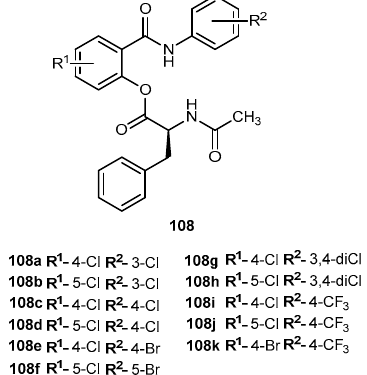
Figure 45. Structures of halogenated salicylanilides and N -acetyl- L -phenylalanine tested against M. tuberculosis strains